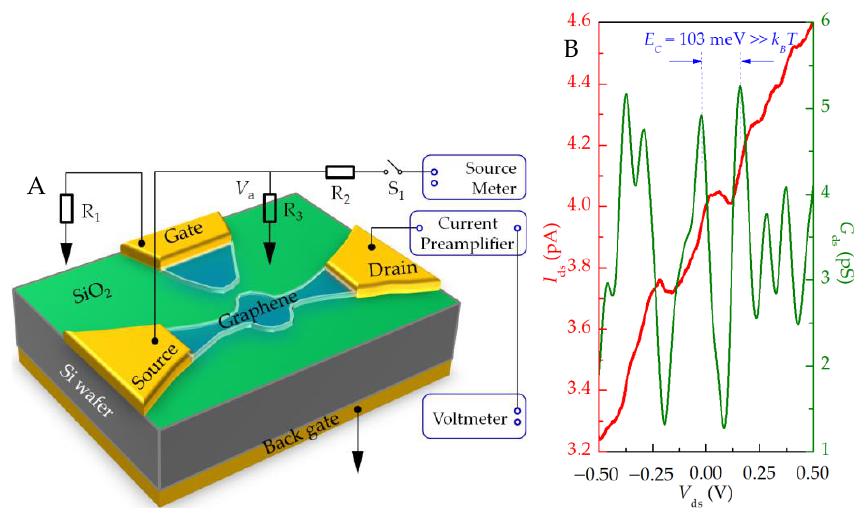
Figure 6. ( A ) Electrical connection of device test. In the measurement, the current preamplification factor is 10 −9 A/V, and the rise time is 300 ms; ( B ) I – V characteristic test curve of source – drain. The red curve corresponds to the left ordinate, indicating the source leakage current; The green curve corresponds to the ordinate on the right, indicating the differential conductance.